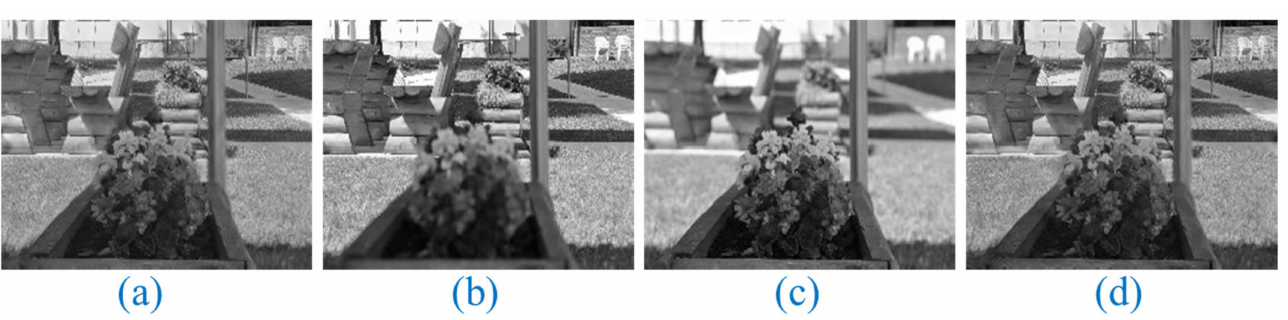
Figure 5. Multi-focus image of a wine bottle from various perspectives. Original Image: ( a ), Multi- focus Input Images: ( b , c ), and Proposed Fusion: ( d ).